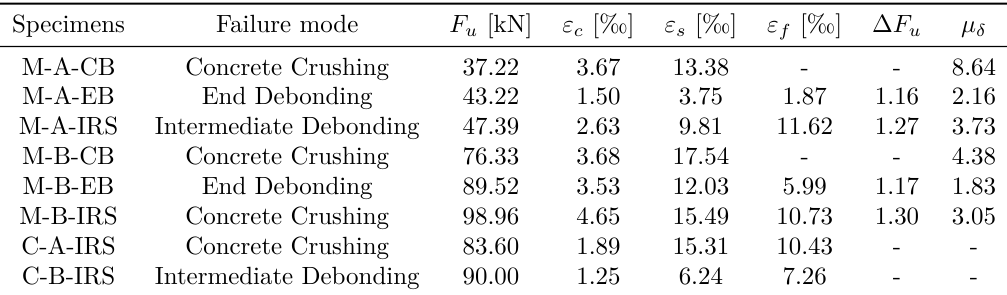
Table 5. Experimental